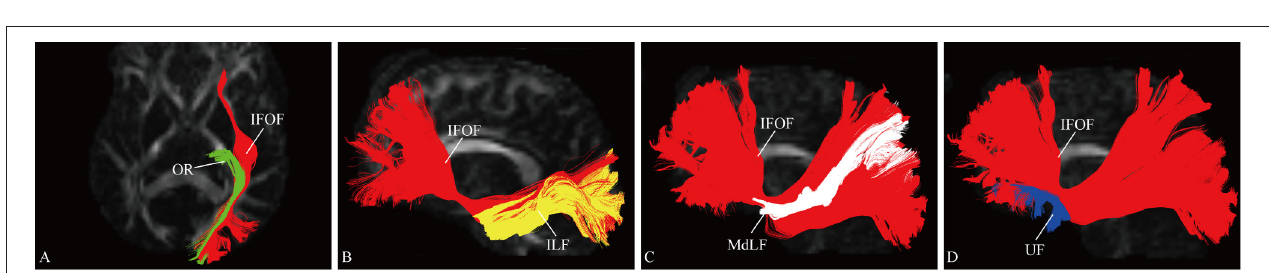
FIGURE 4 | The cortical endpoints of the IFOF and its five subcomponents (subject 1, left hemisphere). (A) A diagram of the five subcomponents. (B) IFOF-I originated from the frontal pole cortex to the inferior occipital lobe, the occipital pole, the middle occipital lobe, the superior occipital lobe, and the superior parietal lobe. (C) IFOF-II originated from the orbito-frontal cortex to the occipital pole, the inferior occipital gyrus, the pericalcarine, the middle occipital lobe, the superior occipital lobe and the fusiform gyrus, and the superior parietal lobe. (D) IFOF-III originated from the inferior frontal gyrus (i.e., pars opercularis, pars triangularis, and pars orbitalis) to the inferior occipital gyrus, the middle occipital lobe, the occipital pole, the superior occipital lobe, the angular gyrus, the superior parietal lobe, and the postcentral gygus. (E) IFOF-IV originated from the middle frontal gyrus to the occipital pole, the inferior occipital gyrus, the middle occipital lobe, the superior occipital lobe, the angular gyrus, the superior parietal lobe, and the postcentral gygus. (F) IFOF-V originated from the superior frontal gyrus to the occipital pole, the inferior occipital gyrus, the middle occipital lobe, the superior occipital lobe, the superior parietal lobe, the angular gyrus, and the postcentral gygus. FP, frontal pole; OFC, orbito-frontal cortex; Pop, pars opercularis; Ptr, pars triangularis; Por, pars orbitalis; MFG, middle frontal gyrus; SFG, superior frontal gyrus; AG, angular gyrus; SPL, superior parietal lobule; PG, postcentral gygus; SOL, superior occipital lobe; MOL, middle occipital lobe; IOL, inferior occipital lobe; FG, fusiform gyrus; Opo, occipital